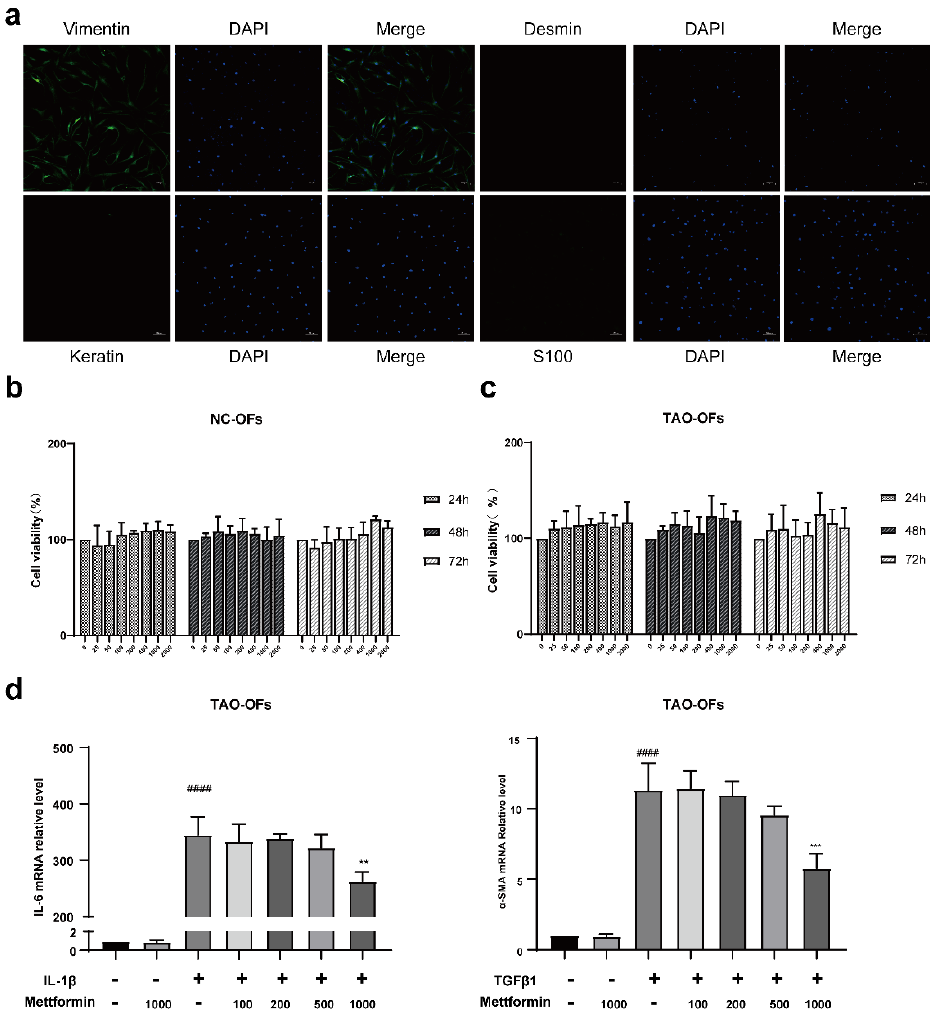
Figure 2. Fibroblast identification and determination of metformin in vitro. ( a ) IF analysis of the expressions of vimentin, desmin, keratin, and s100. Scale bar, 100 µm. ( b , c ) CCK8 assay results showing that the different concentrations of metformin did not affect the viability of TAO and NC OFs. ( d ) The mRNA expressions of IL-6 and α -SMA in TAO-OFs treated with different concentrations of metformin were determined by qPCR. #### p < 0.0001, compared with the control group, ** p < 0.01, *** p < 0.001 compared with the IL- 1β or TGF - β1 group (ANOVA).